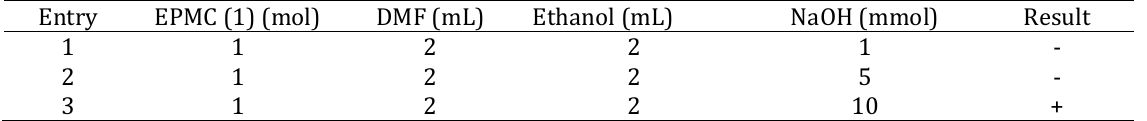
Table I. Optimization of the amount of NaOH for the synthesis of N,N -dimethyl- p -methoxycinnamamide (5) Entry